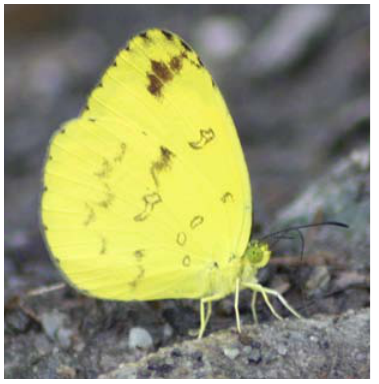
Image 29. Troides helena cerberus (female)